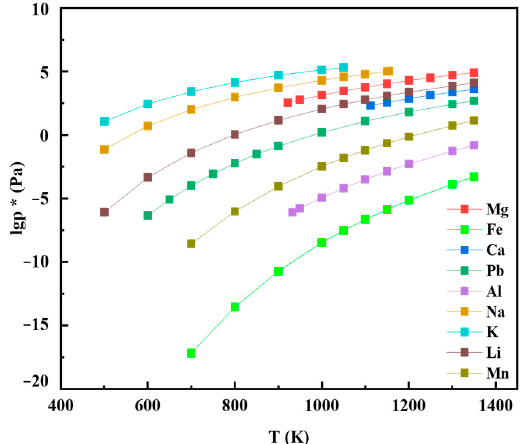
Figure 1. Relationship between the saturation vapor pressure and temperature for di ff erent metals.